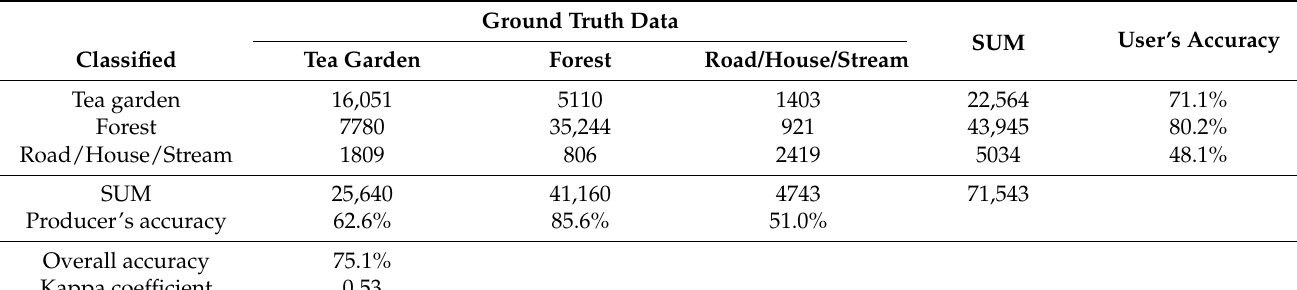
Table 4. Confusion matrix between ground truth and classified land use in